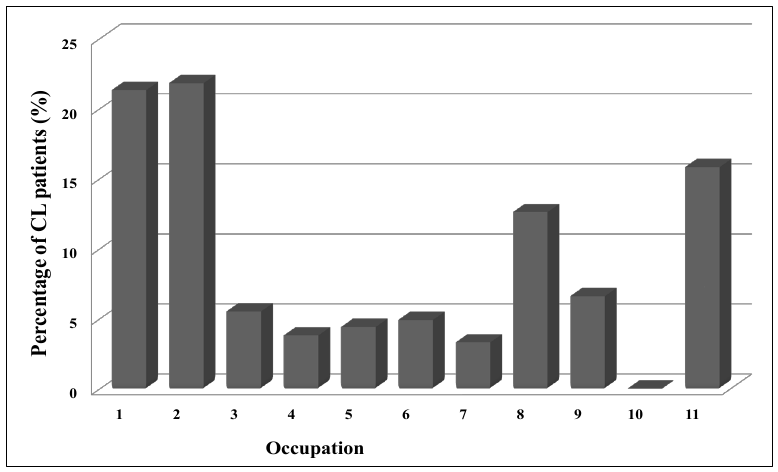
Figure 4: Frequency distribution of different occupations of CL patients in Hambantota district, Sri Lanka. 1: Students; 2: House wives; 3: Unemployed; 4: Laborer; 5: Farmer; 6: Fisherman; 7: Skill worker; 8: Self-employed; 9: Government servant; 10: Military personal; 11: Others (Retired & private sector